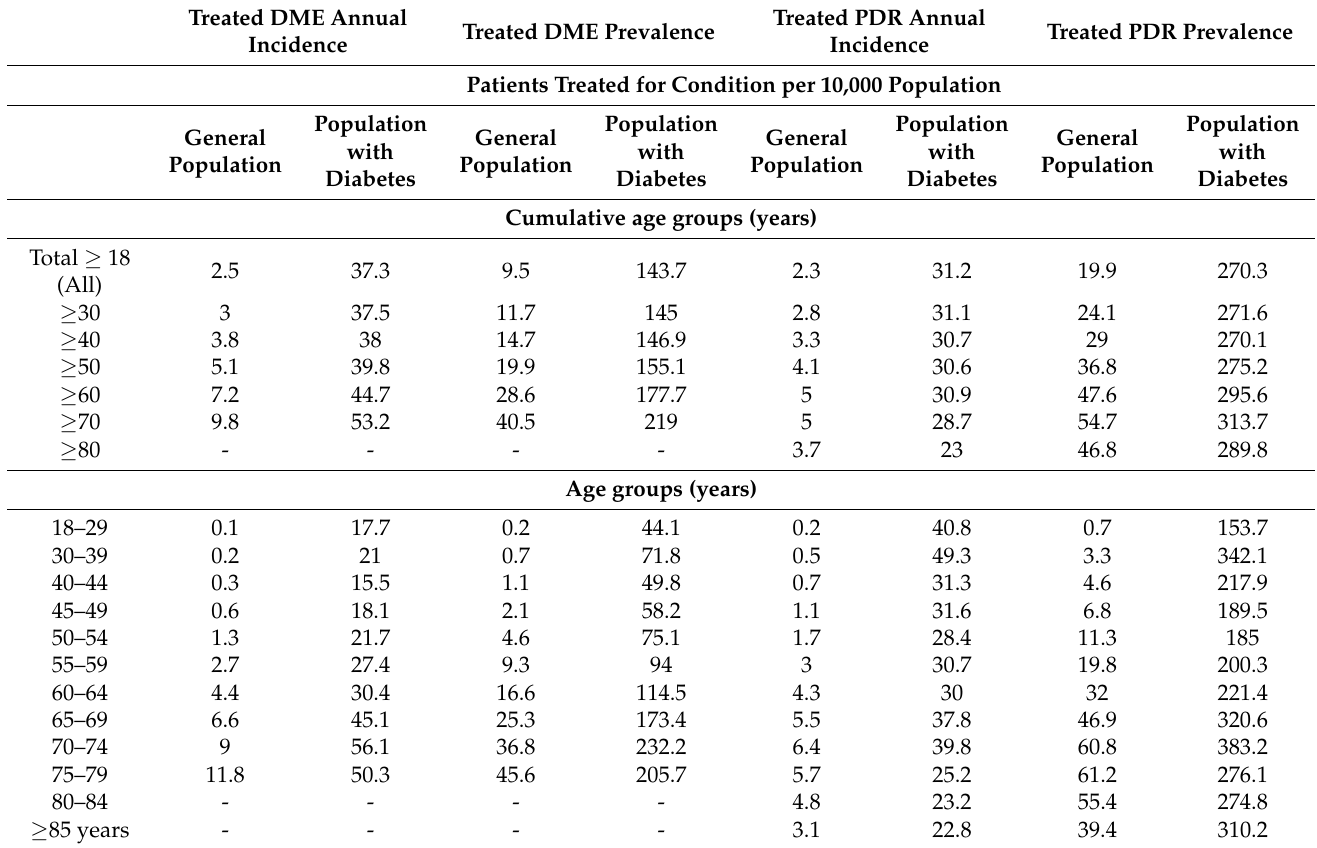
Table 2. Treated DME and PDR incidence and prevalence in 2018 by age group. Incidence and prevalence of treated DME and PDR in 2018 are presented by cumulative age group and by age group. Incidence and prevalence are presented per 10,000 adults in the general population in France and per 10,000 adults with diabetes in